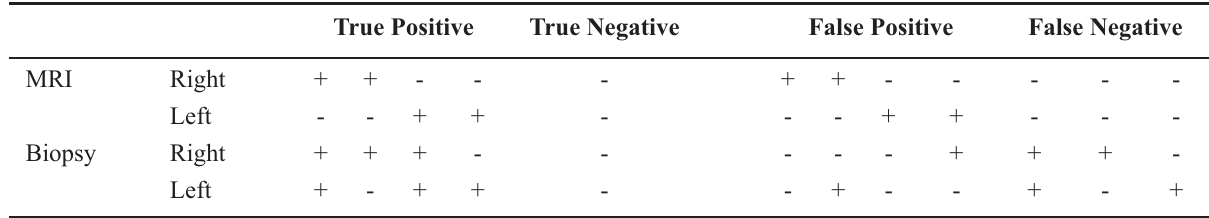
Table 1 – Definition of outcome categories. A positive diagnosis was considered correct if the reader correctly identified tumor and correctly noted the side of the prostate gland containing cancer. In patients in which tumor was bilateral, the reader was considered correct regardless of which side was indicated as dominant. True Positive